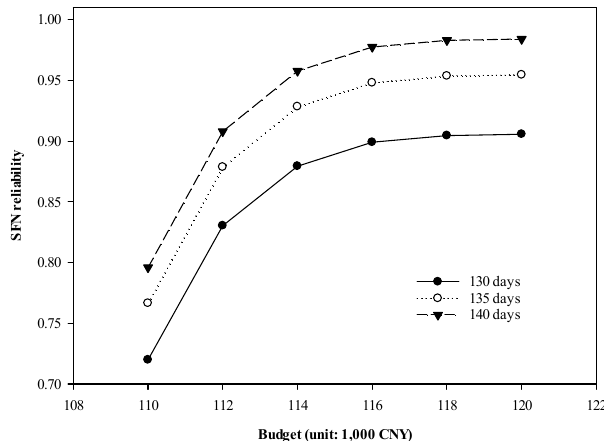
Figure 3. The patterns of the experimental results.